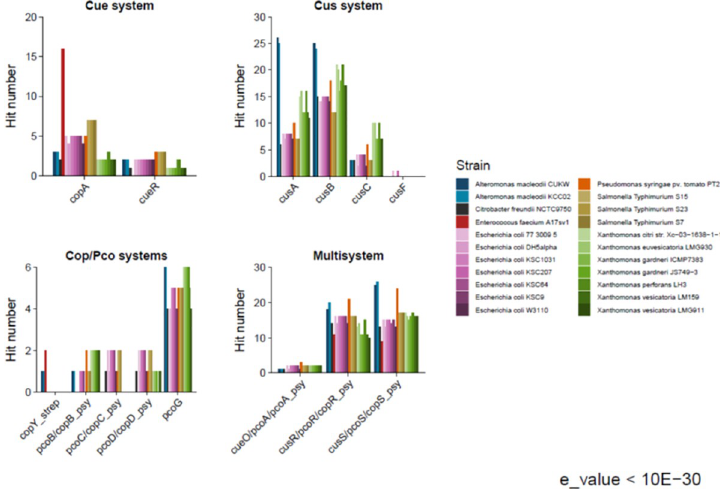
Fig 4. Number of hits to models of copper-associated proteins in CUKW and KCC02 in comparison to bacterial species isolated from copper-rich environments. Model names (Table 7) are shown on the X-axis. The number of hits per protein and per species were counted and grouped by the category of interest: Cue, Cus, Cop/Pco, and Multisystem. An e-value of 1 − 30 served as the threshold for defining a hit.